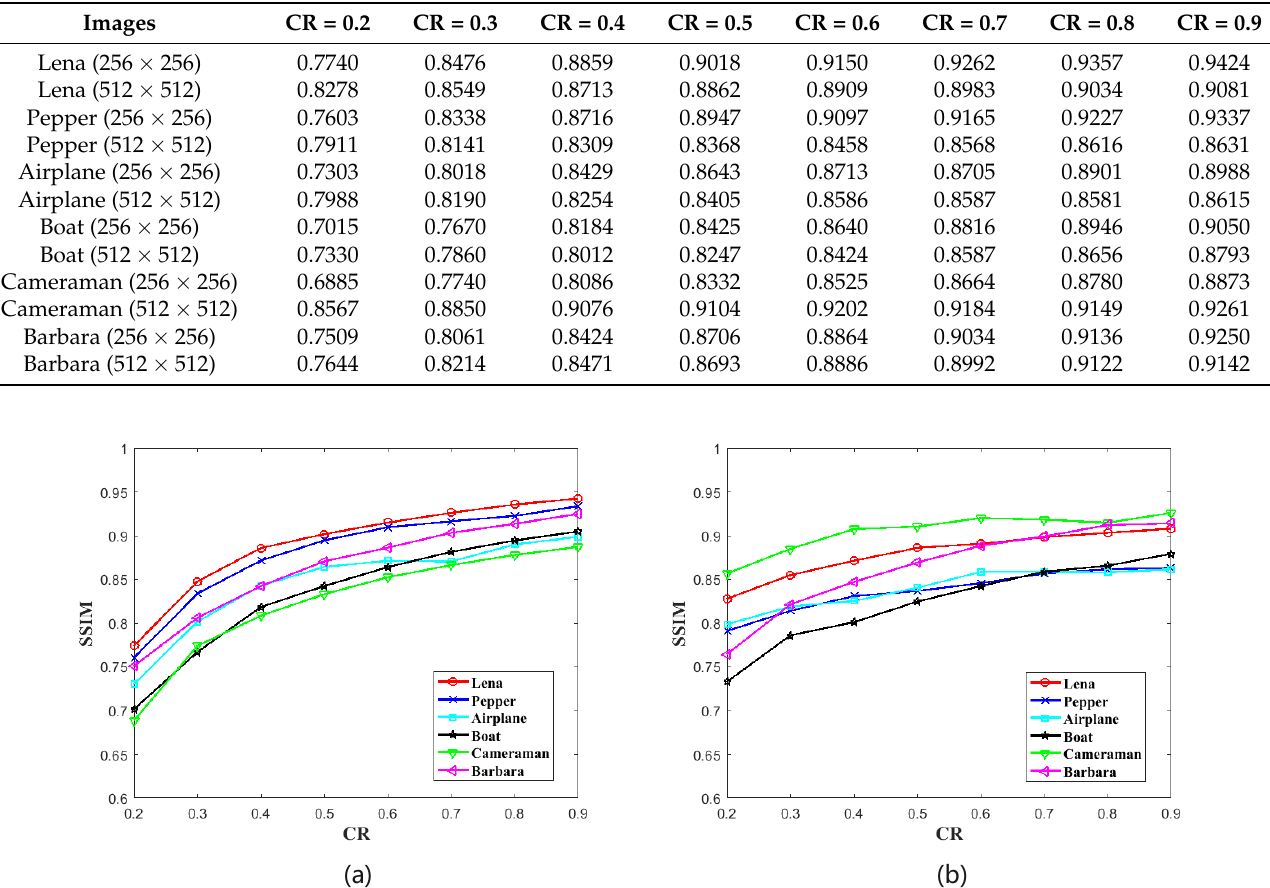
Table 2. The Structural Similarity Index Measurement (SSIM) test results.